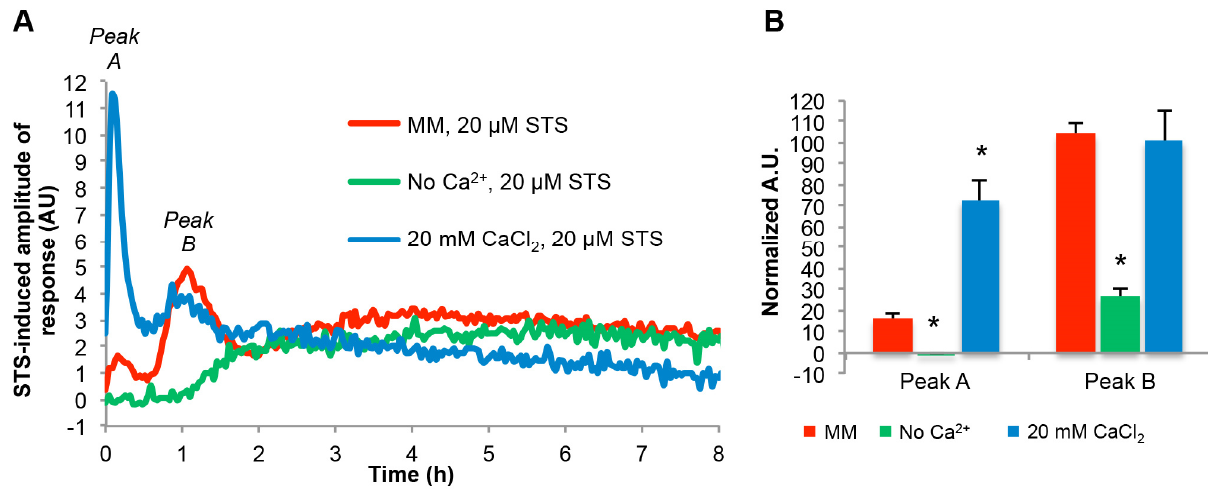
FIGURE 2: Extracellular Ca 2+ availability affects intracellular Ca 2+ dynamics in response to staurosporine. (A) Aequorin-expressing wild type cells were cultured for 6 hours in the indicated media and after the addition of 20 μM staurosporine (STS), luminescence was followed over time. The STS-induced amplitude of response is shown. (B) Quantification (in arbitrary units) of the cytosolic Ca 2+ peaks “A” and “B” (indicat- ed in A). *, p-value ≤